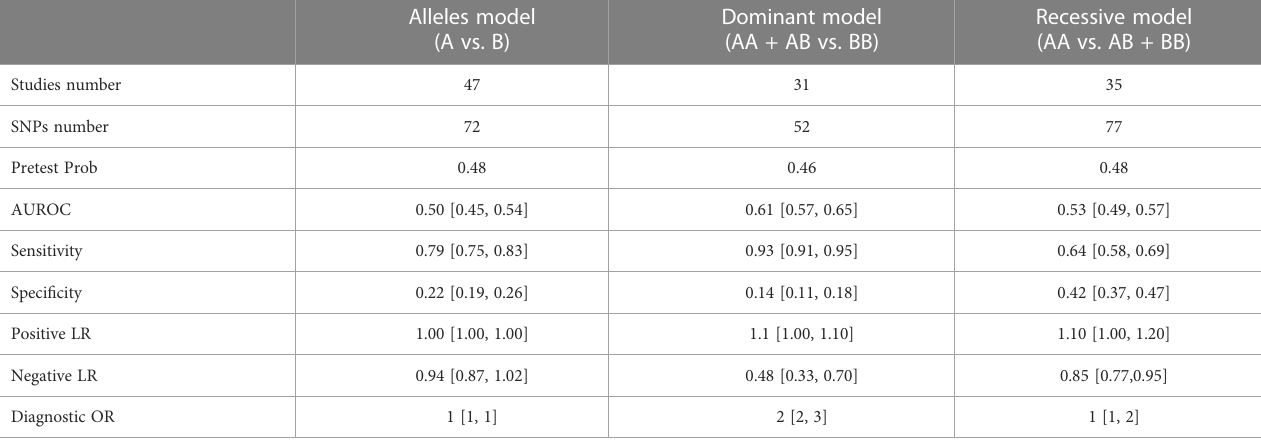
TABLE 2 SNPs ’ diagnostic performance evaluation in skin